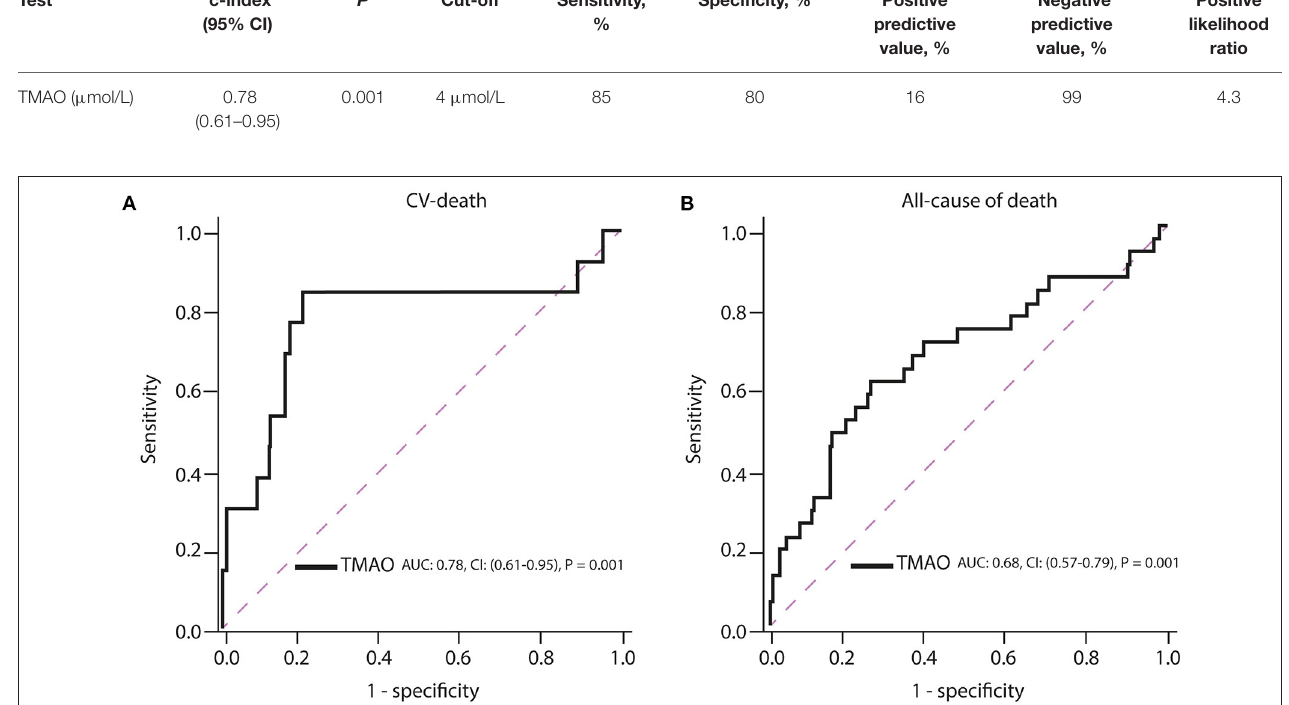
FIGURE 3 | Receiver operating characteristic (ROC) curves of TMAO for prediction of (A) cardiovascular death and (B) all-cause of death. AUC, area under the curve; CI, confidence interval.